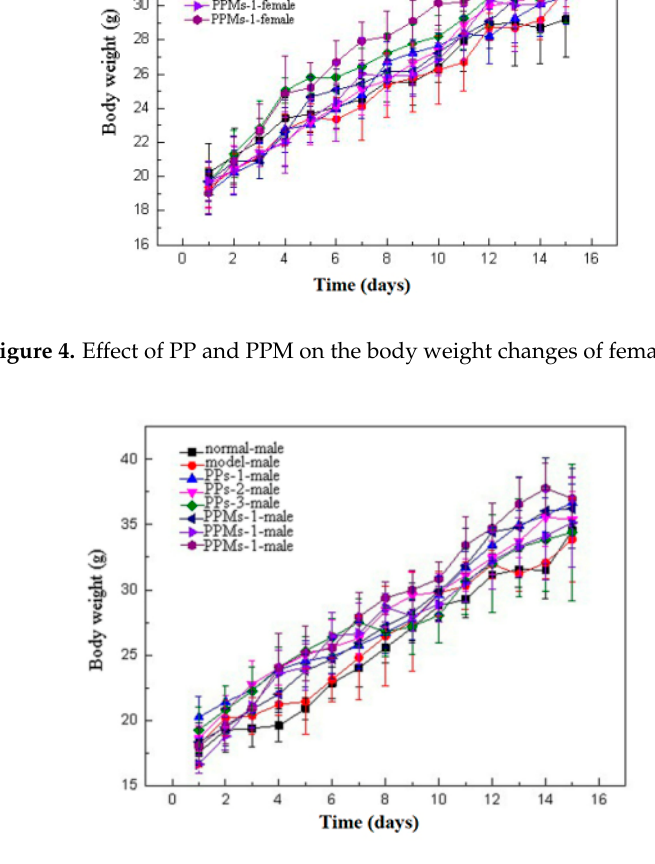
Figure 5. Effect of PP and PPM on the body weight changes of male mice.